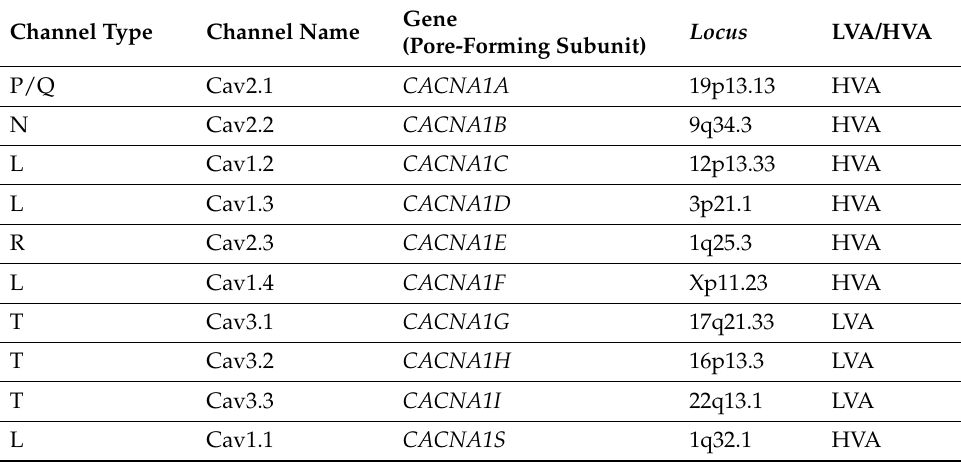
Table 2. Biophysical and pharmacological properties of voltage-gated Ca 2+ channels.